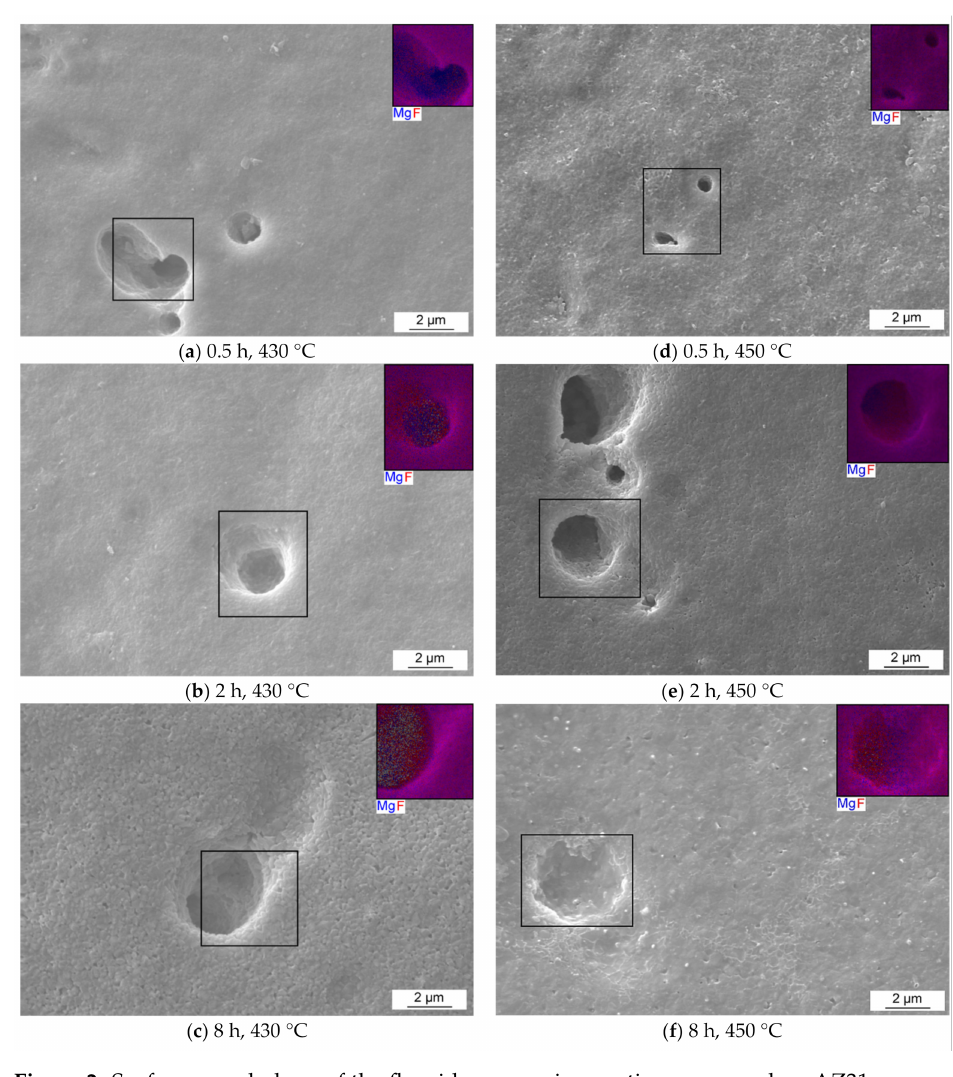
Figure 2. Surface morphology of the fluoride conversion coatings prepared on AZ31 magnesium alloy, SEM, EDS.